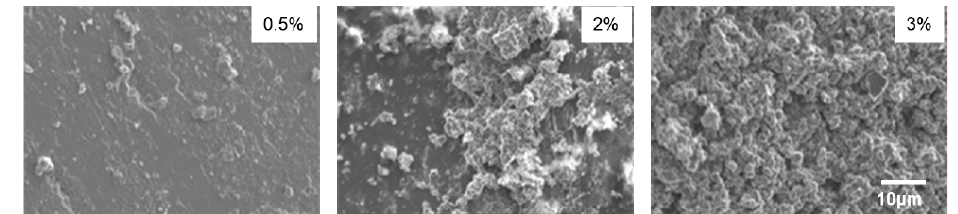
Figure 2. Evolution of the surface structures of the siloxane + Ca(OH) 2 coatings. The concentrations (w / w) of the Ca(OH) 2 nanoparticles in the dispersions that were deposited on marble are shown in the upper right corner of each image.